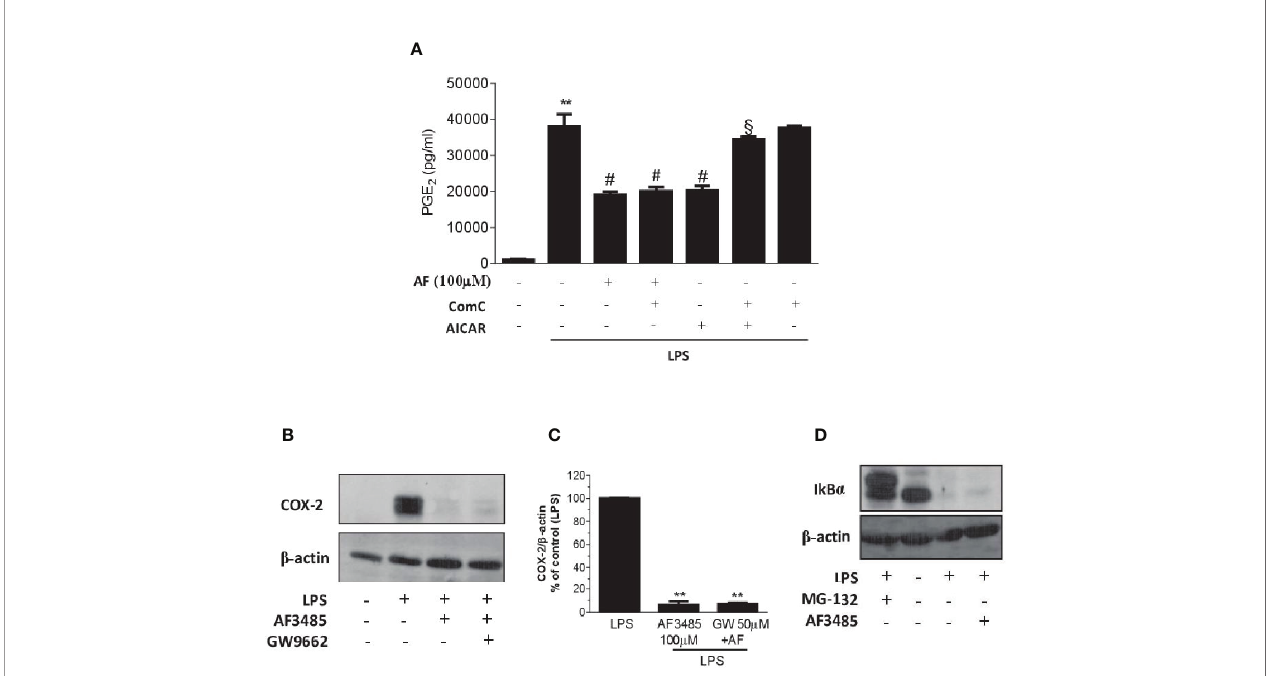
FIGURE 5 | Effects of pharmacological modulation of AMPK, PPAR g or IkB a on the inhibition of PGE 2 biosynthesis and COX-2 expression by AF3485 in human blood leukocytes. (A) AF3485 (100 µM) was incubated with 1 ml of heparinized human whole blood stimulated with LPS (10 µg/ml) for 24 h, in the presence or absence of ComC (10 µM) or AICAR (1 mM); plasma PGE 2 was assessed by immunoassay; values are reported as mean ± SEM, n=3. **P < 0.01 versus vehicle; # P < 0.01 versus LPS; § P < 0.01 versus AICAR. (One-way ANOVA and Student's t-test). (B) LPS-stimulated monocytes (0.8-1x10 6 cells) were treated with AF3485 (100 µM) or vehicle (DMSO), in the presence or absence of the PPAR g antagonist GW9662 (50 µM) for 24 h; COX-2 levels were assessed by Western blot and b - actin was used as protein loading control; a representative experiment (from three independent experiments) is shown. (C) Densitometric analysis of COX-2 expression normalized to b -actin; values are reported as % of control (LPS), mean ± SEM, n = 3. **P < 0.01 versus LPS (Student's t-test). (D) Levels of I k B a assessed by Western blot in THP-1 cells (1x10 6 cells) stimulated with LPS (10 µg/ml) for 1 h in the absence or presence of AF3485 (100 µM) and the effect of the proteasome inhibitor MG-132 (10 µM) was evaluated; b -actin levels were used as protein loading